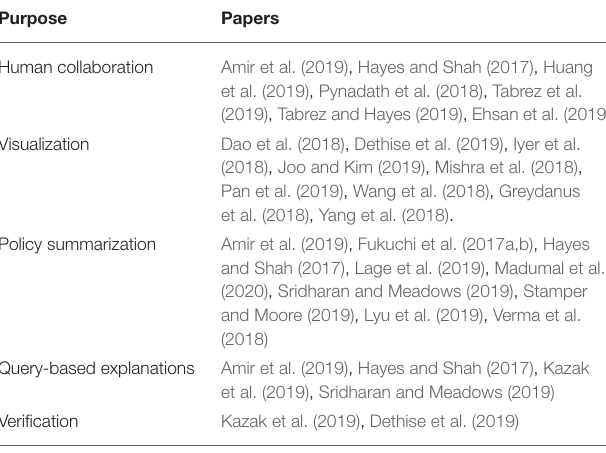
TABLE 1 | A summary of the papers reviewed, categorized by